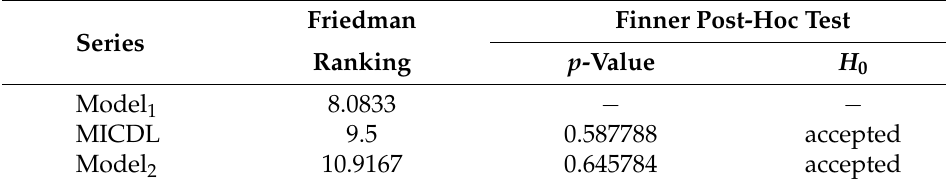
Table 9. FAR test and Finner post hoc test based on the R 2